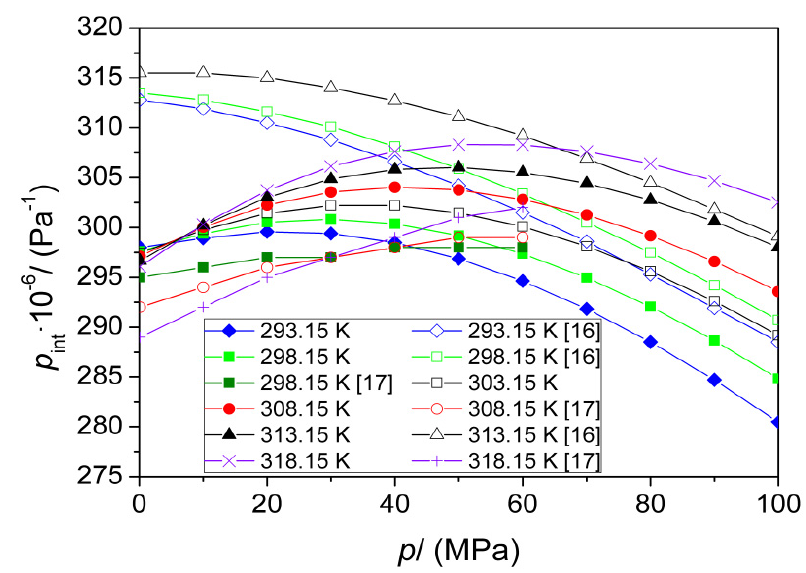
Figure 11. Comparison of the internal pressure of 1-butanol as a function of pressure obtained in this work with those obtained from the p ρ T literature data [16,17].